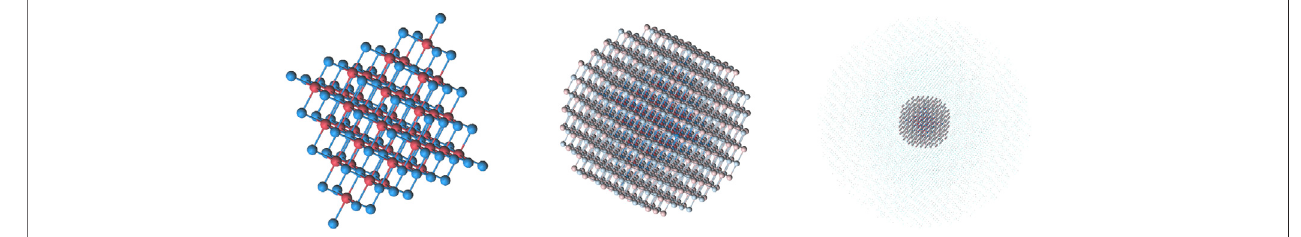
FIGURE 2 | The structure of Mg-IV cluster. From left to right: the quantum part, AIMPs layer (model potentials are shown as pale spheres), point charges surrounding the embedded